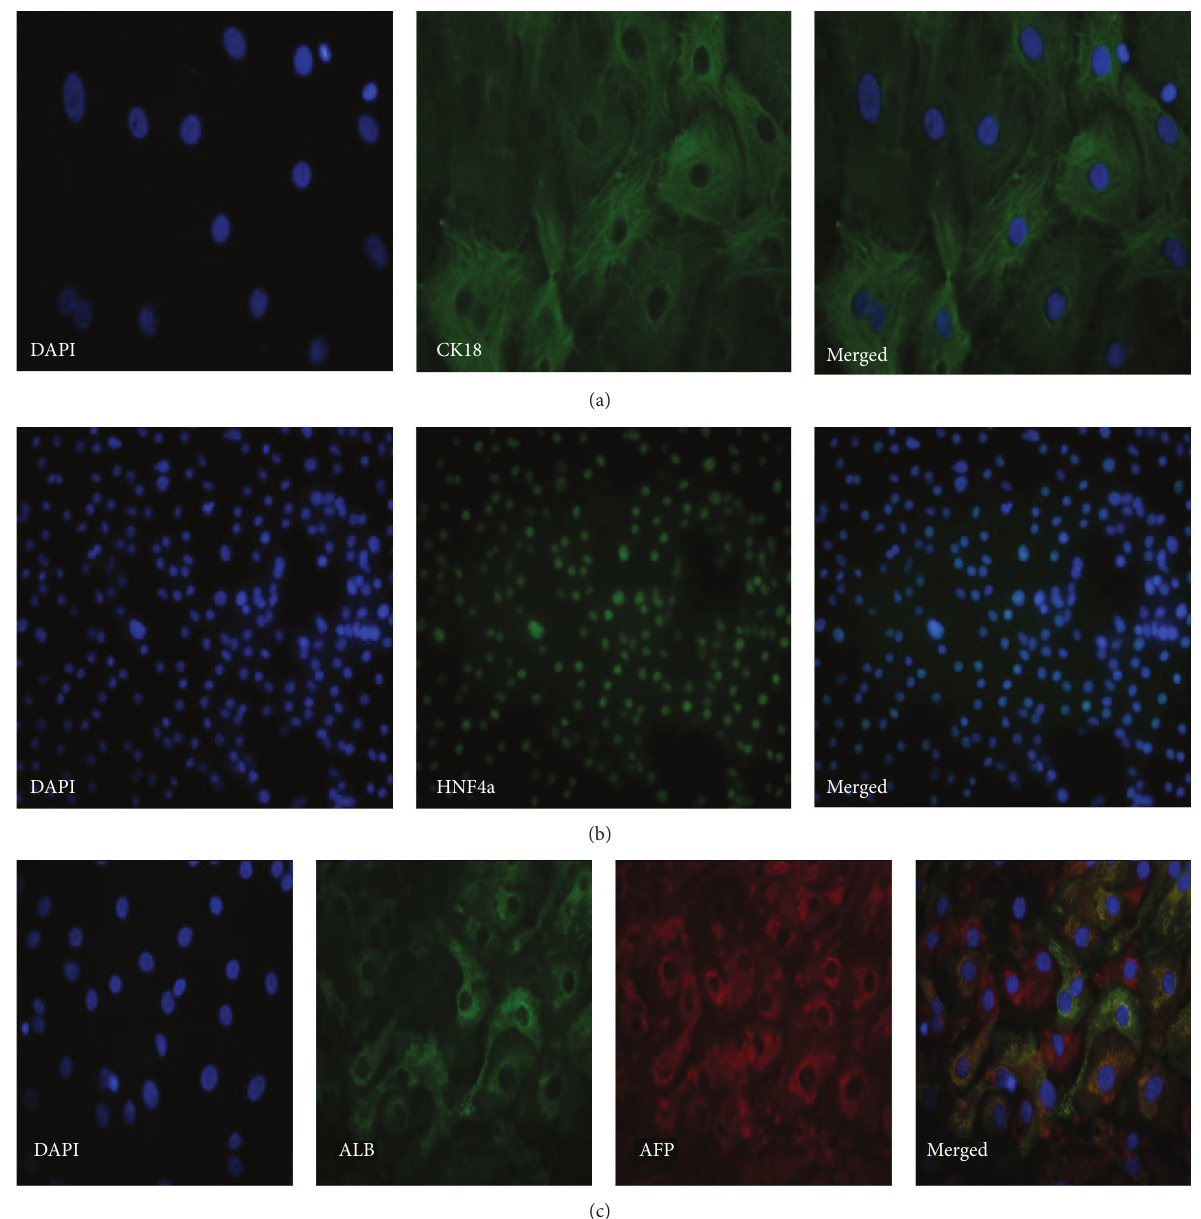
Figure 10: Representative micrographs illustrating the expression of markers at day 25. Panel (a) shows staining for CK18 (ChiPSC6b, 40x magnification). Panel (b) shows staining for HNF4a (AS034, 20x magnification). Panel (c) shows stainings for ALB and AFP (ChiPSC6b, 20x